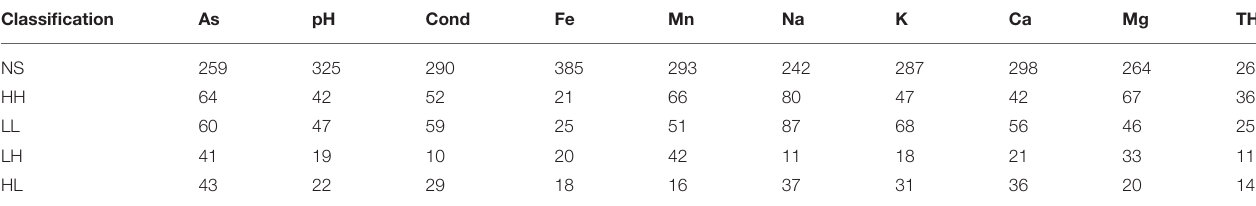
TABLE 3 | Number of sites per hot-spot classification (where NS, not-significant; HH, high-high; LL, low-low; LH, low-high; and HL, high-low).